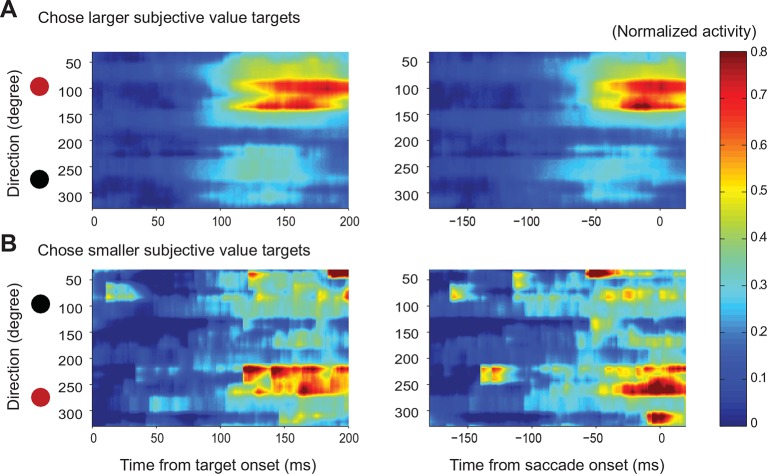
Action value maps for trials with variable choices.SEF population activity for the option pairs in which the monkeys chose different options across trials. The circle on top indicates the position of the target with the higher average value, while the circle below indicates the position of the target with the lower average value. The red circle indicates the chosen target, while the black circle indicates the non-chosen target. The time-direction maps are aligned on target (left panels) and saccade (right panels) onset. (A) SEF population activity on trials, in which the monkey chose the more valuable target. (B) SEF population activity on trials, in which the monkey chose the less valuable target. The SEF neurons whose preferred direction coincided with the chosen target location strongly increased their activity, irrespective of the target’s value. This indicates that SEF neurons not only encode the relative action value of a saccade in their preferred direction, but also the saccade choice. SEF, supplementary eye field.